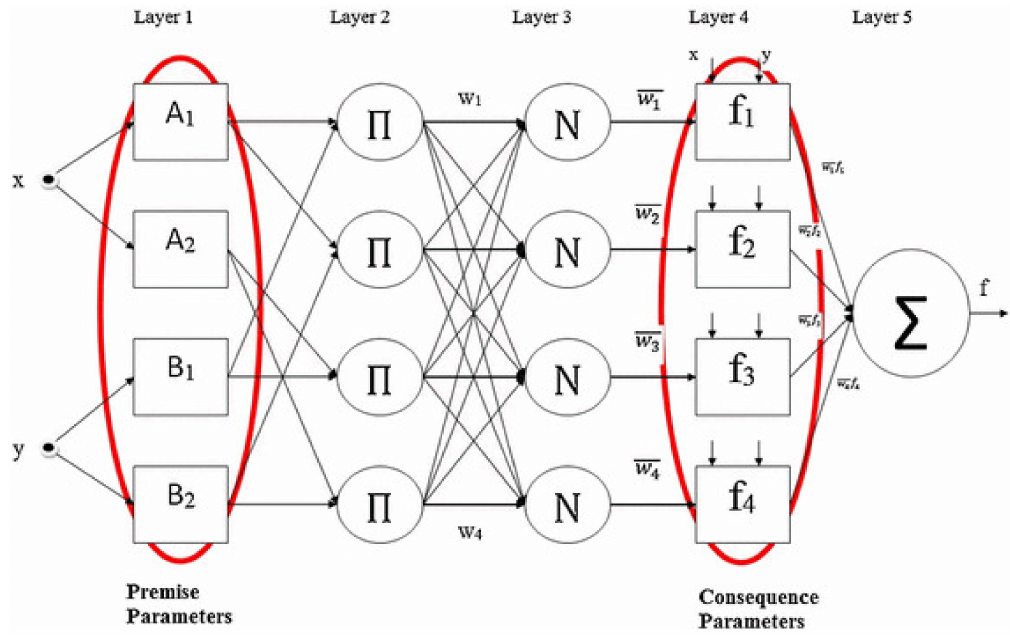
Figure 1. The adaptive neuro-fuzzy inference system (ANFIS)